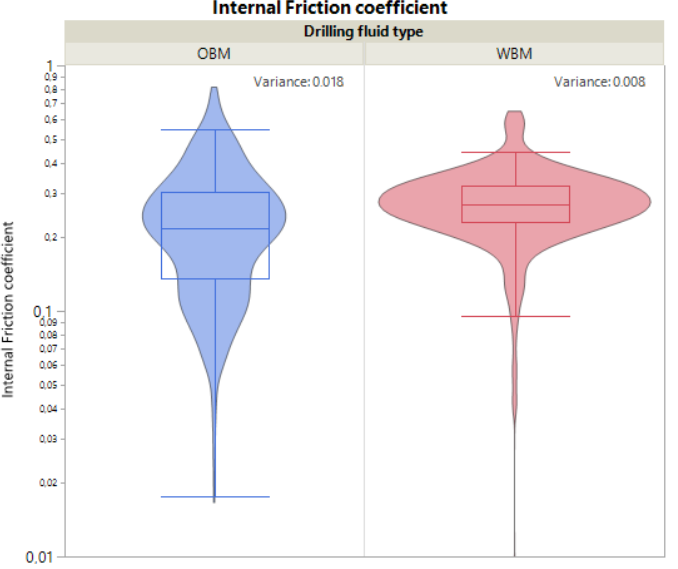
Figure 7. Violin plot of the internal friction factor coefficient under constant normal force for the OBM and